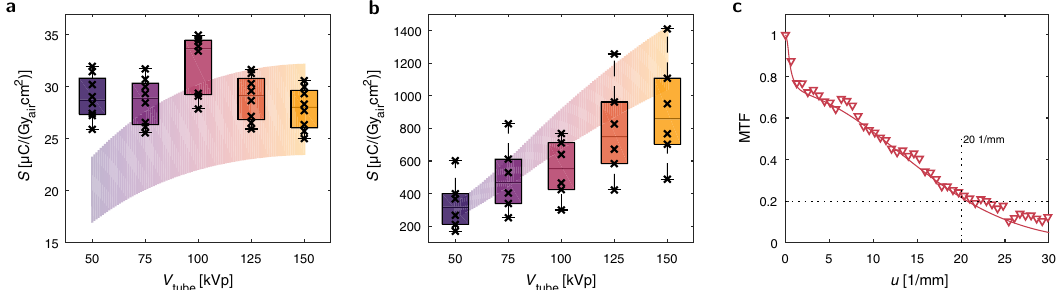
Fig. 3 X-ray sensitivity and spatial resolution. a , b X-ray sensitivities S of the planar ( a ) and the folded ( b ) detector as a function of the utilized X-ray tube voltage V tube . The experimentally determined sensitivities are represented by box plots. The individual pixel sensitivities are also shown as symbols (crossed markers). The theoretical sensitivity prediction is depicted by the coloured areas. c Presampled modulation transfer function MTF of the folded detector as a function of the spatial frequency u . The MTF is determined by a numerical (markers) and an analytical (solid lines)